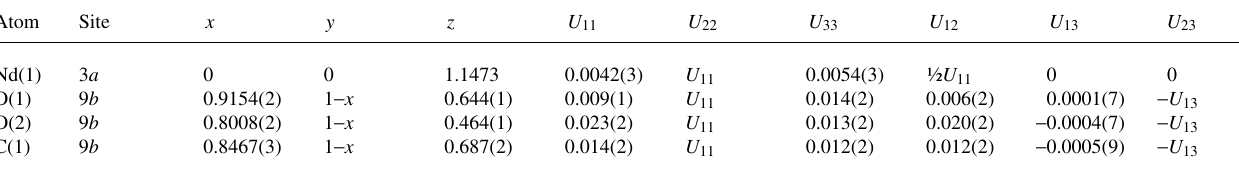
Table 3. Atomic coordinates and displacement parameters (in Å 2 )